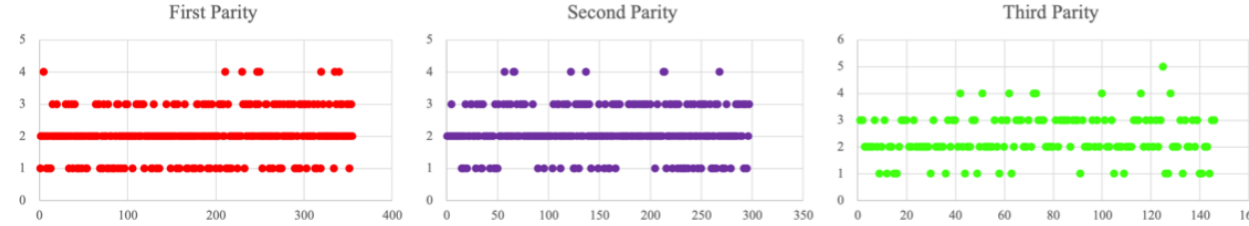
Figure 2. Scatterplots of litter size for the three parities. A dot represents a Nubian goat.